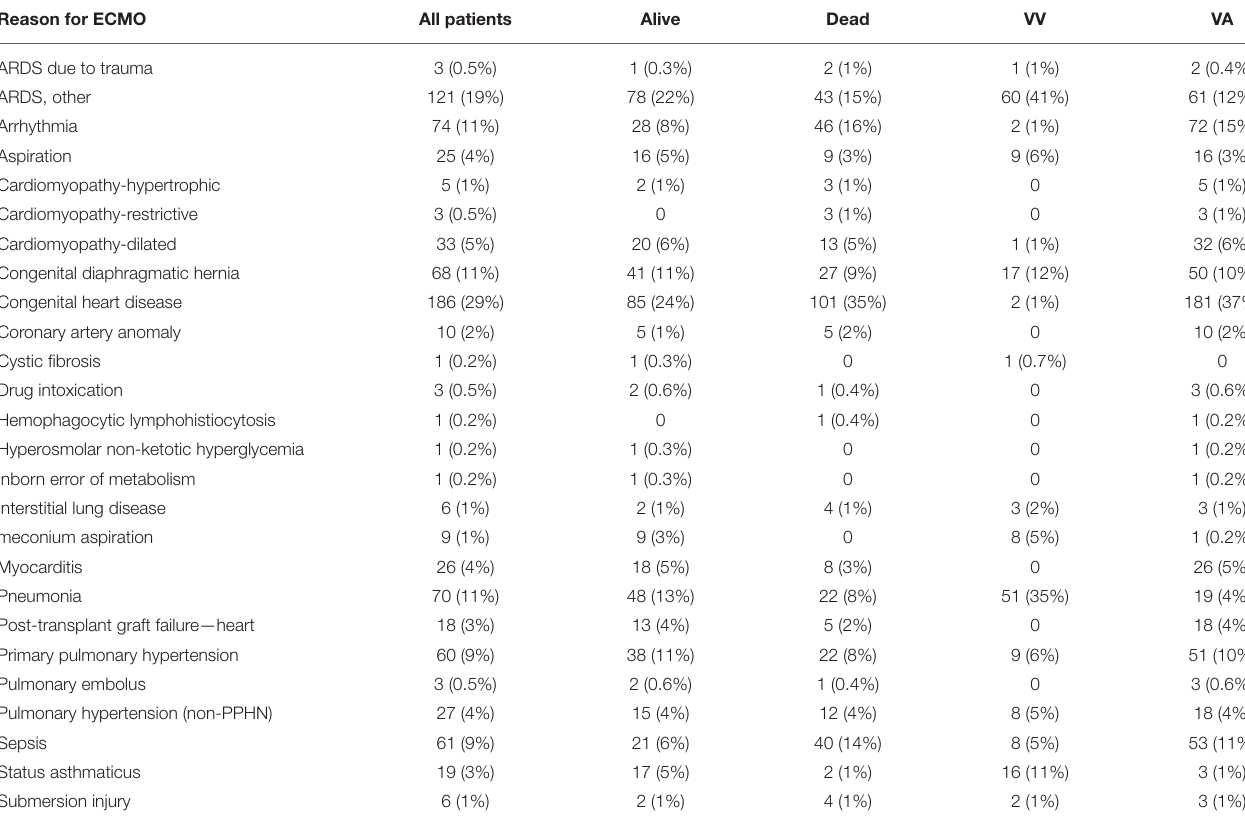
TABLE 2 | Diagnostic indications for ECMO. Reason for ECMO